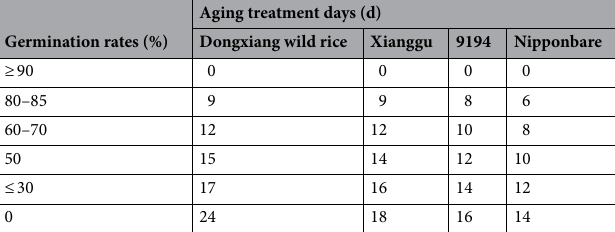
Table 1. Germination rates of different accessions after aging